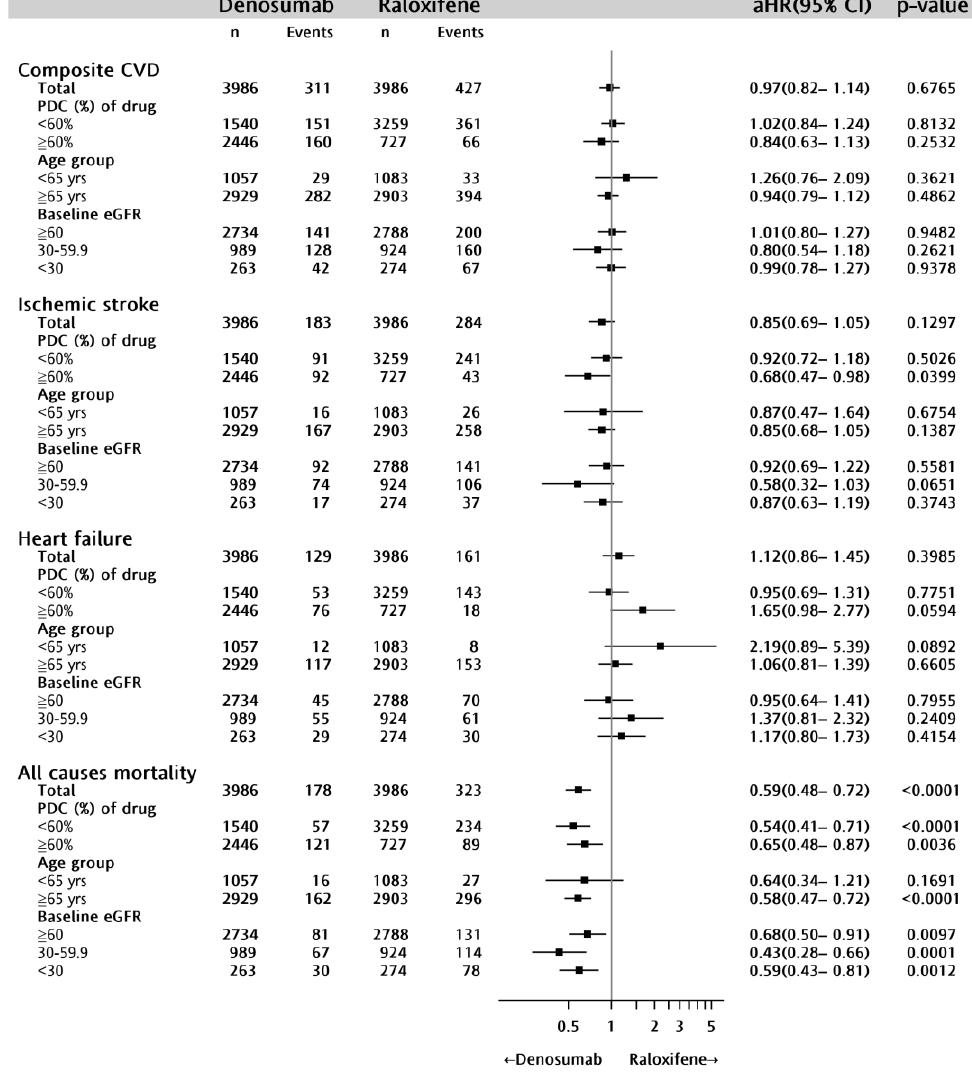
Figure 3. Stratified analyses of the risk of composite CVD, ischemic stroke, heart failure, and all– cause mortality between the denosumab and raloxifene groups (denosumab versus raloxifene). CVD, cardiovascular disease; aHR, adjusted hazard ratio; PDC, proportion of days covered; and eGFR, estimated glomerular filtration rate. # Adjusted for age, sex, baseline eGFR, mean dose of drug, CVD-related comorbidities, baseline comorbidities (abnormal thyroid function, obstructive sleep apnea, and fracture), and concomitant medications (anti-thrombotic agents, lipid-lowering agents, antidiabetics, antihypertensive agents, and other osteoporosis therapy).